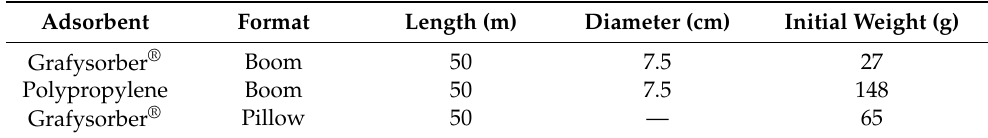
Table 2. Samples for tank tests.